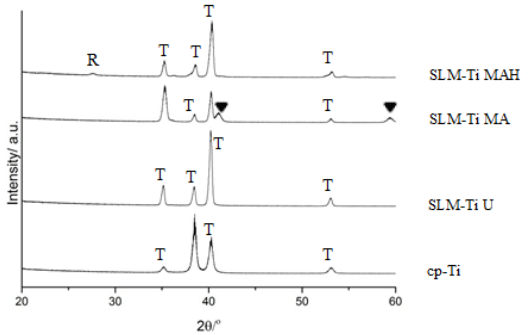
Figure 3. TF-XRD profiles of cp-Ti and SLM-Ti with or without the mixed acid and heat treatment. R: rutile, T: α-titanium, ▼ : TiH x .